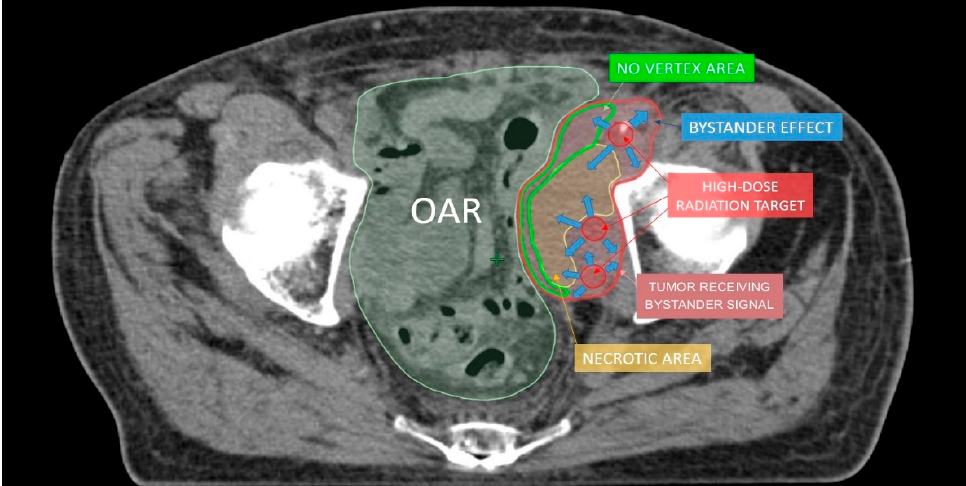
Figure 3. Dose distribution in the axial plane ( left ), the coronal plane ( middle ), and the sagittal plane ( right ).